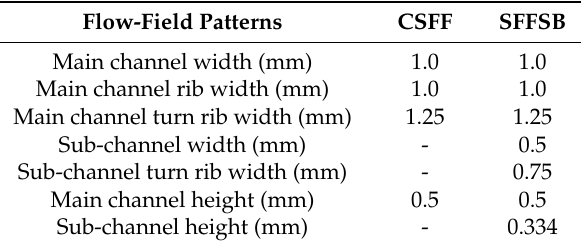
Table 1. Geometrical details of the two flow-fields of CSFF and SFFSB used in this